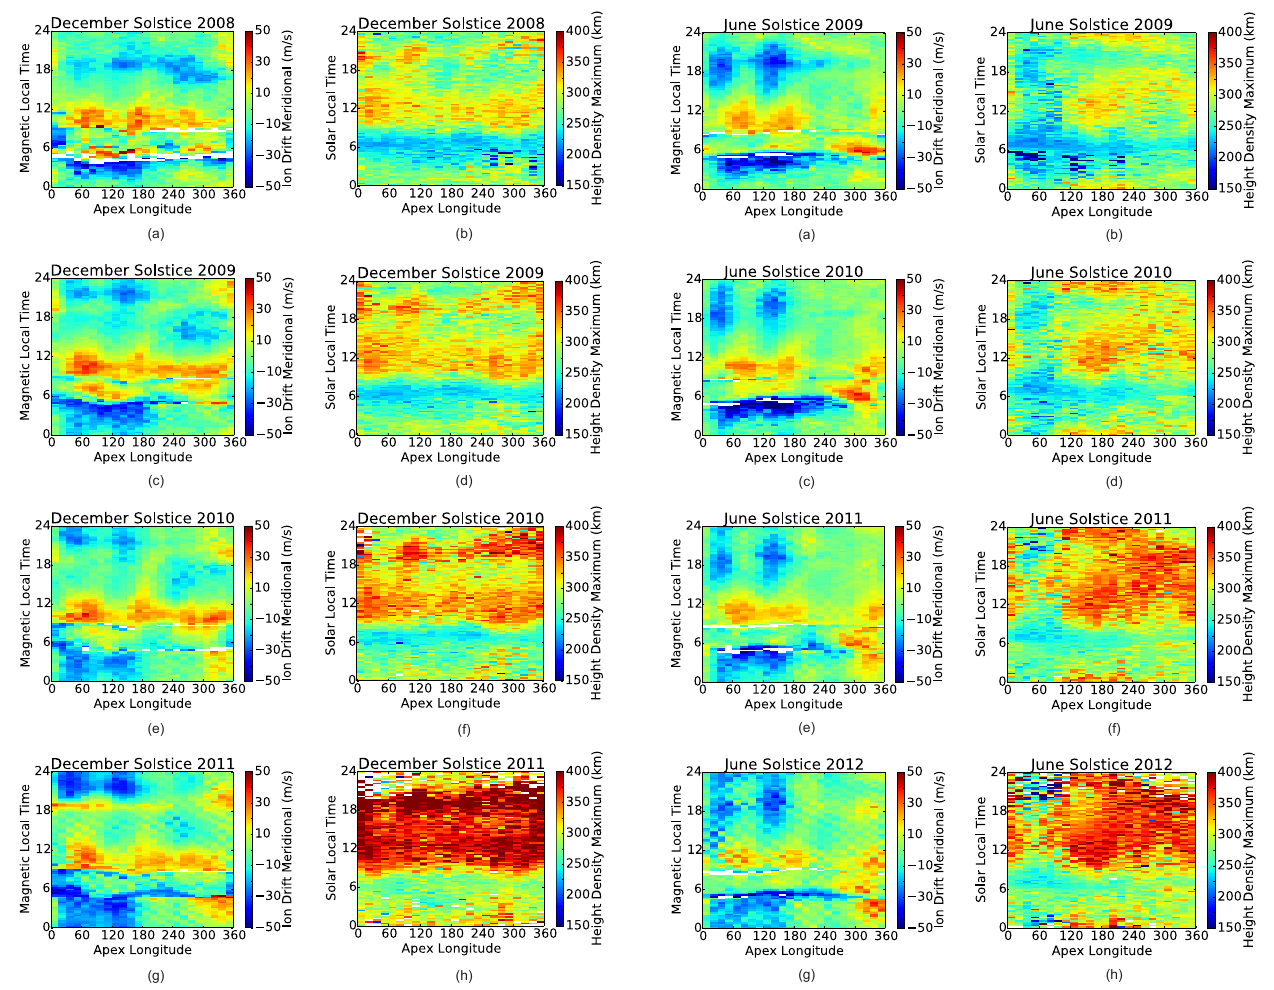
Fig. 6. Left column: median CINDI meridional ion drifts. Right col- umn: median hm F2 near the geomagnetic equator determined by COSMIC.